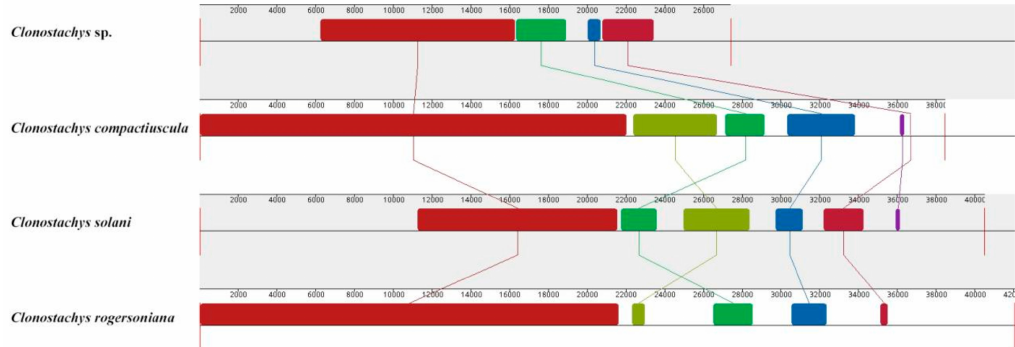
Figure 8. Mitogenome synteny among four Clonostachys species. (Six homologous regions were identified among the four mitogenomes, while the sizes and relative positions of the homologous fragments varied across the